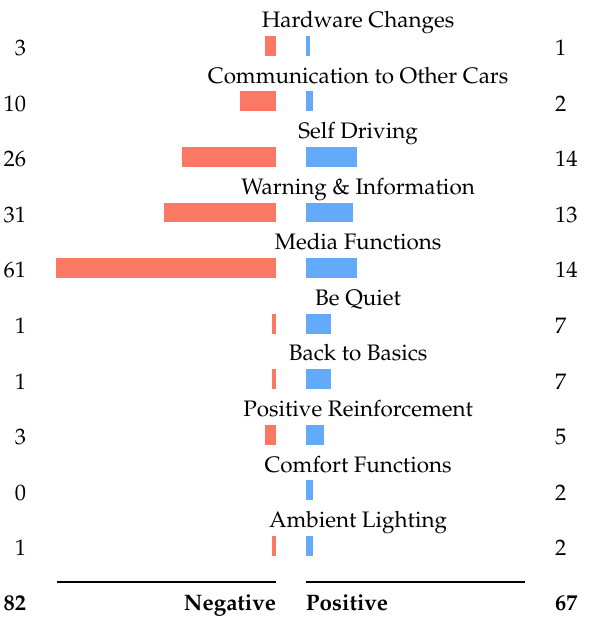
Figure 4. Drivers in negative situations had many ideas for improvement, such as inter-vehicle communication, autonomous driving, improved information management and various media functionalities. Drivers in positive situations provided less input but with similar content, except for the wish that a system should be quiet in nice moments and offer a ‘back-to-basic’ option for electronic assistance